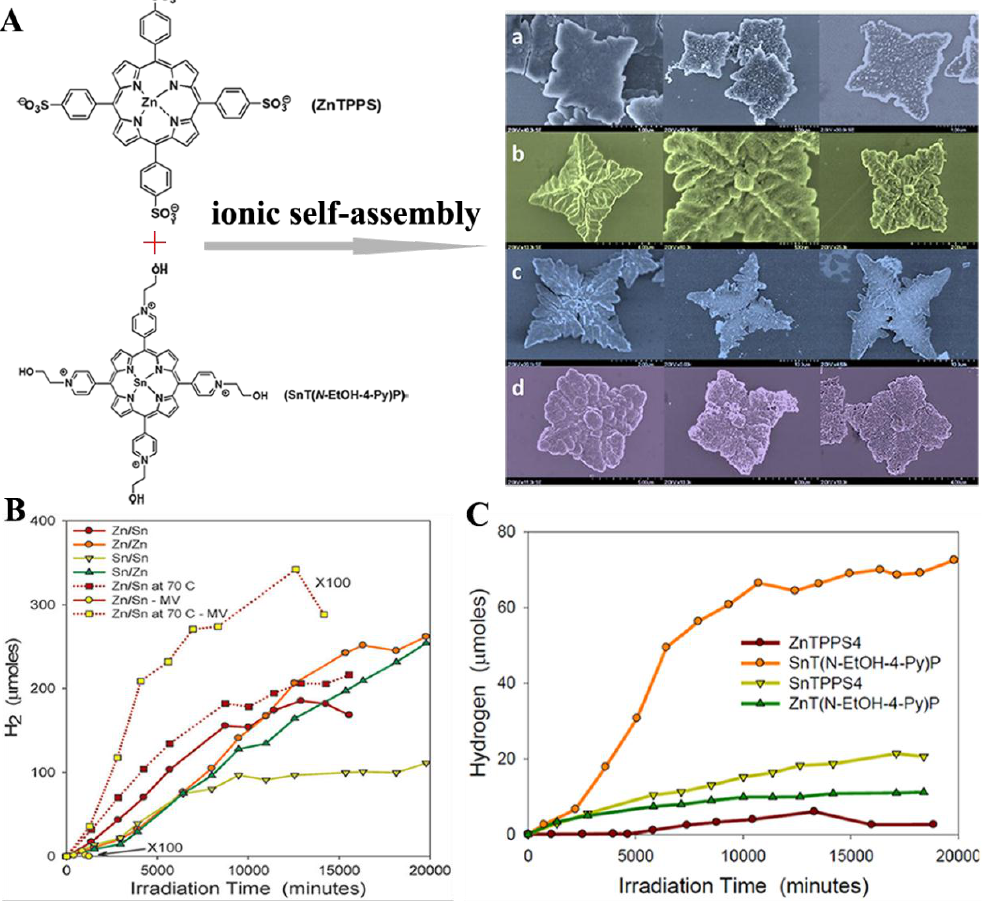
Figure 5. ( A ) SEM images of the structures prepared at room temperature for all four combinations of Zn(II) and Sn(IV) in the two porphyrins (left), the corresponding unwashed platinized clovers (middle) and the washed clovers after two weeks of continuous hydrogen generation (right): Zn/Sn (a), Sn/Zn (b), Zn/Zn (c) and Sn/Sn (d) by ionic self-assembly of Zn(II) tetrakis(4- sulfonatophenyl)porphyrin (ZnTPPS) and Sn(IV) tetrakis( N -2-hydroxyethyl-4-pyridinium)porphyrin (SnT( N -EtOH-4-Py)P). ( B ) Total H 2 generated by the platinized porphyrin clovers (Zn/Sn, Zn/Zn, Sn/Sn, Sn/Zn) grown at room temperature (solid lines) and at 70 °C for the Zn/Sn clovers (dotted lines) versus irradiation time with visible light from a tungsten lamp. Zn/Sn clovers with (dark red symbols) and without (yellow) methylviologen. The latter are expanded by a factor of 100. ( C ) Hydrogen generated by free porphyrins at the same concentrations as in the clovers as a function of irradiation time by white light at 0.15 W cm −2 . Reproduced with permission from [66]. Copyright 2011, Royal Society of Chemistry.